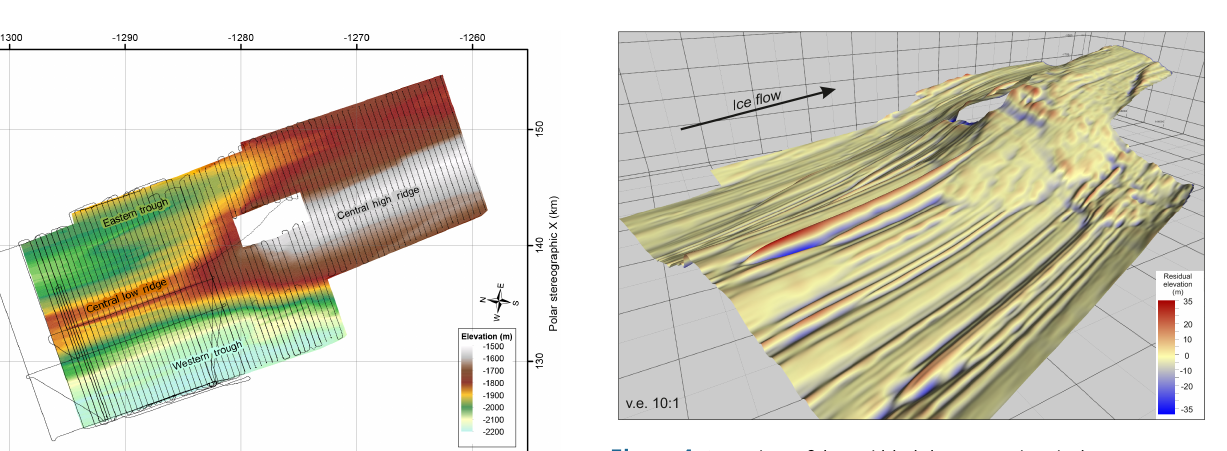
Figure 4. 3-D view of the gridded data set. View is downstream to- wards the south-east; vertical exaggeration is approximately 10 to 1. The bed elevation surface has been colour-coded by residual eleva- tion to emphasise the landforms. Residual elevation was computed by differencing the bed elevation surface with a smoothed version which used a 2km × 2km spatial smoothing filter. Bold grid lines are spaced 4km apart in the horizontal directions and 250m apart in the vertical